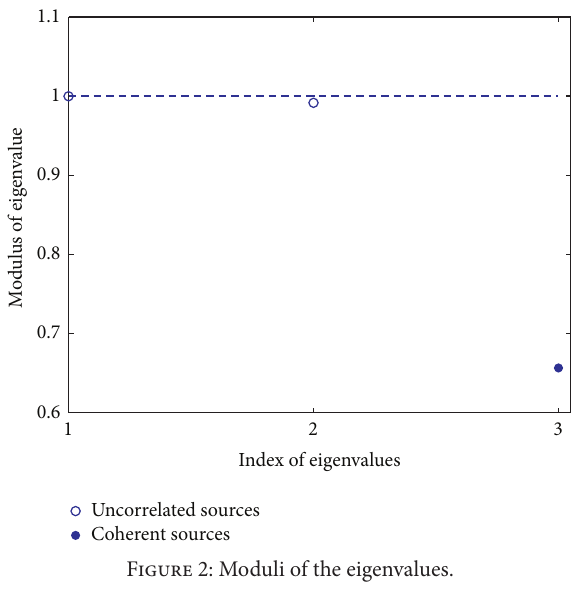
Figure 2: Moduli of the eigenvalues.